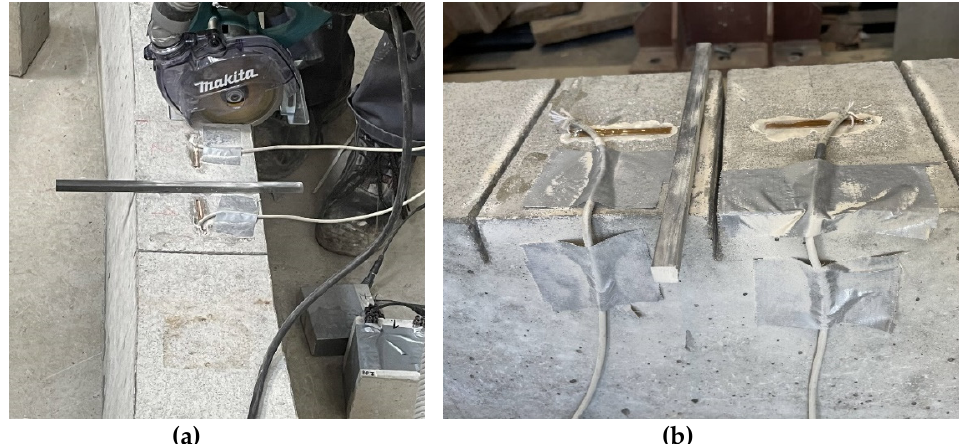
Figure 7. Application of the saw-cut method. Sawing ( a ); final saw-cuts ( b ).